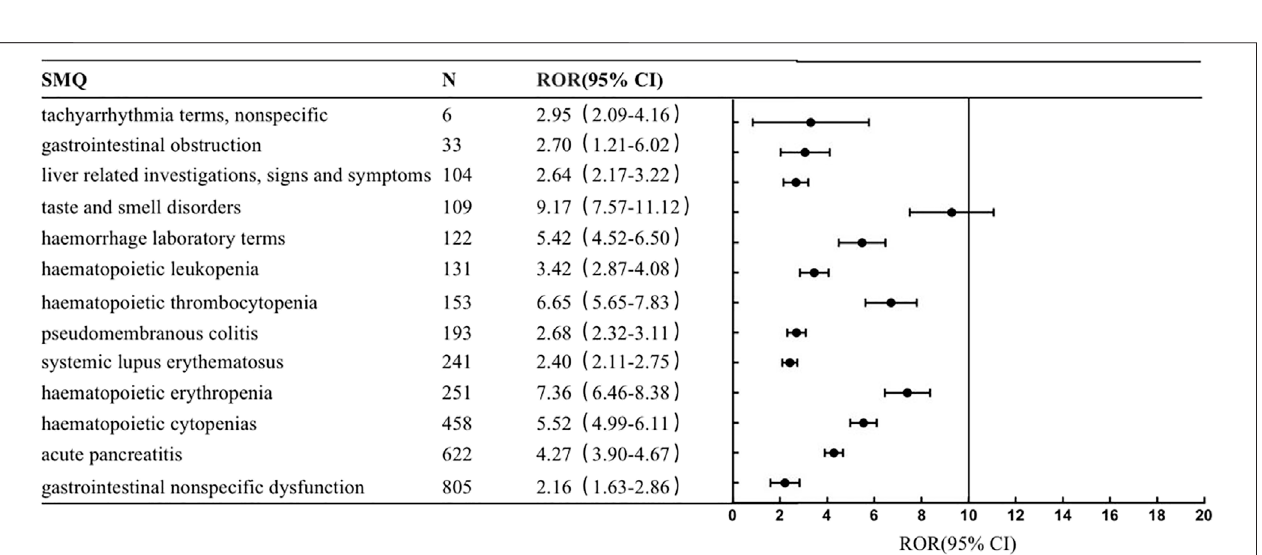
Frontiers in Pharmacology |